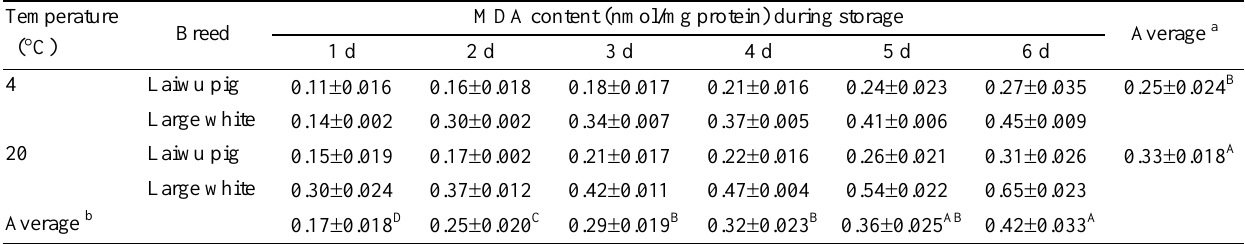
Table 4. MDA content of porcine muscle stored at different days and temperatures